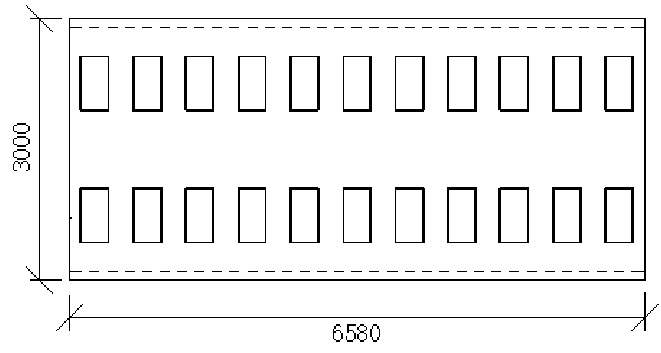
Figure 33. Optimized design of track bed width.